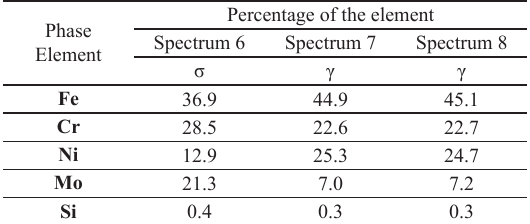
Table 5. Chemical composition (% weight) of precipitate analyzed by SEM EDS. Phase Element